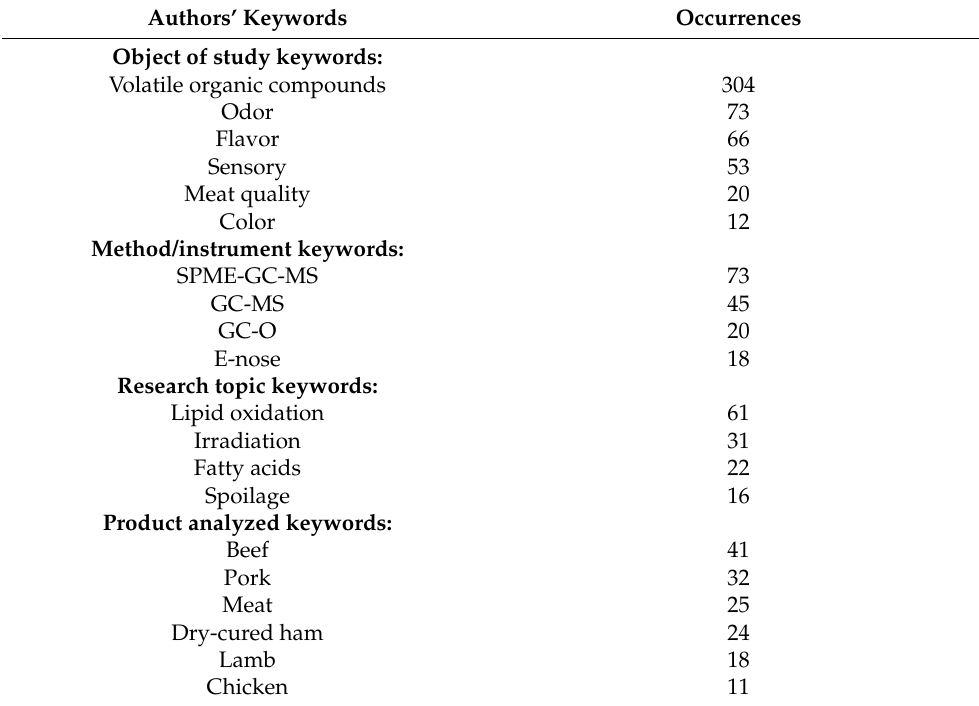
Table 6. Occurrences of the authors’ main keywords and keyword